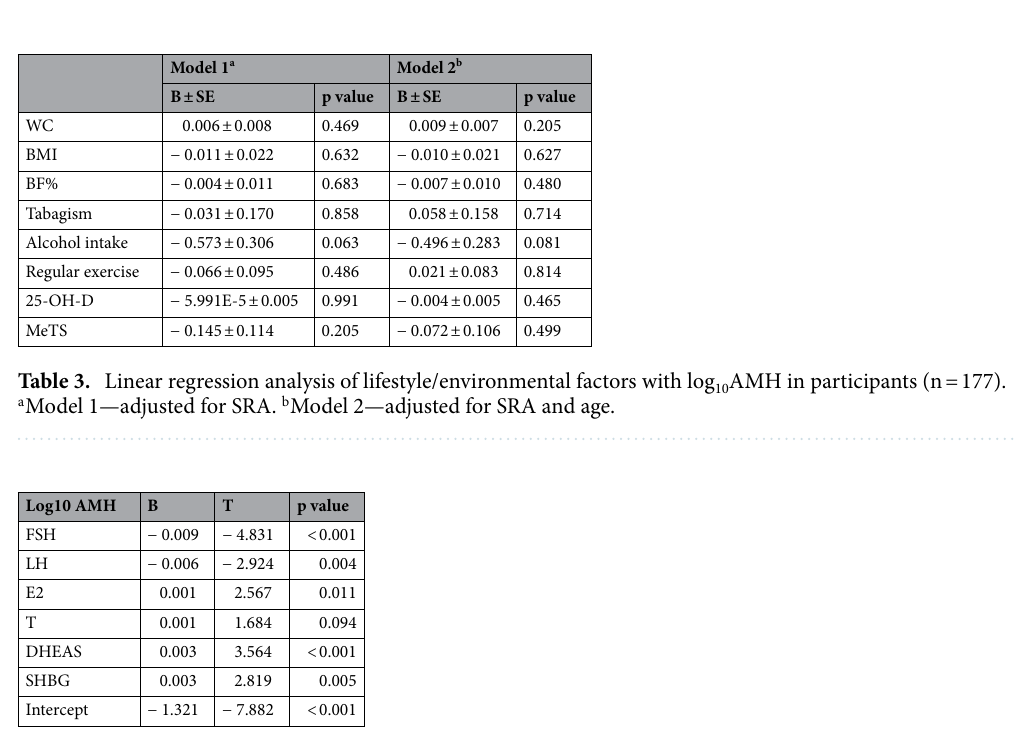
Table 2. Regression coefficients between lifestyle/environmental factors and serum AMH. Overall R 2 = 0.656 (corrected R 2 = 0.635).